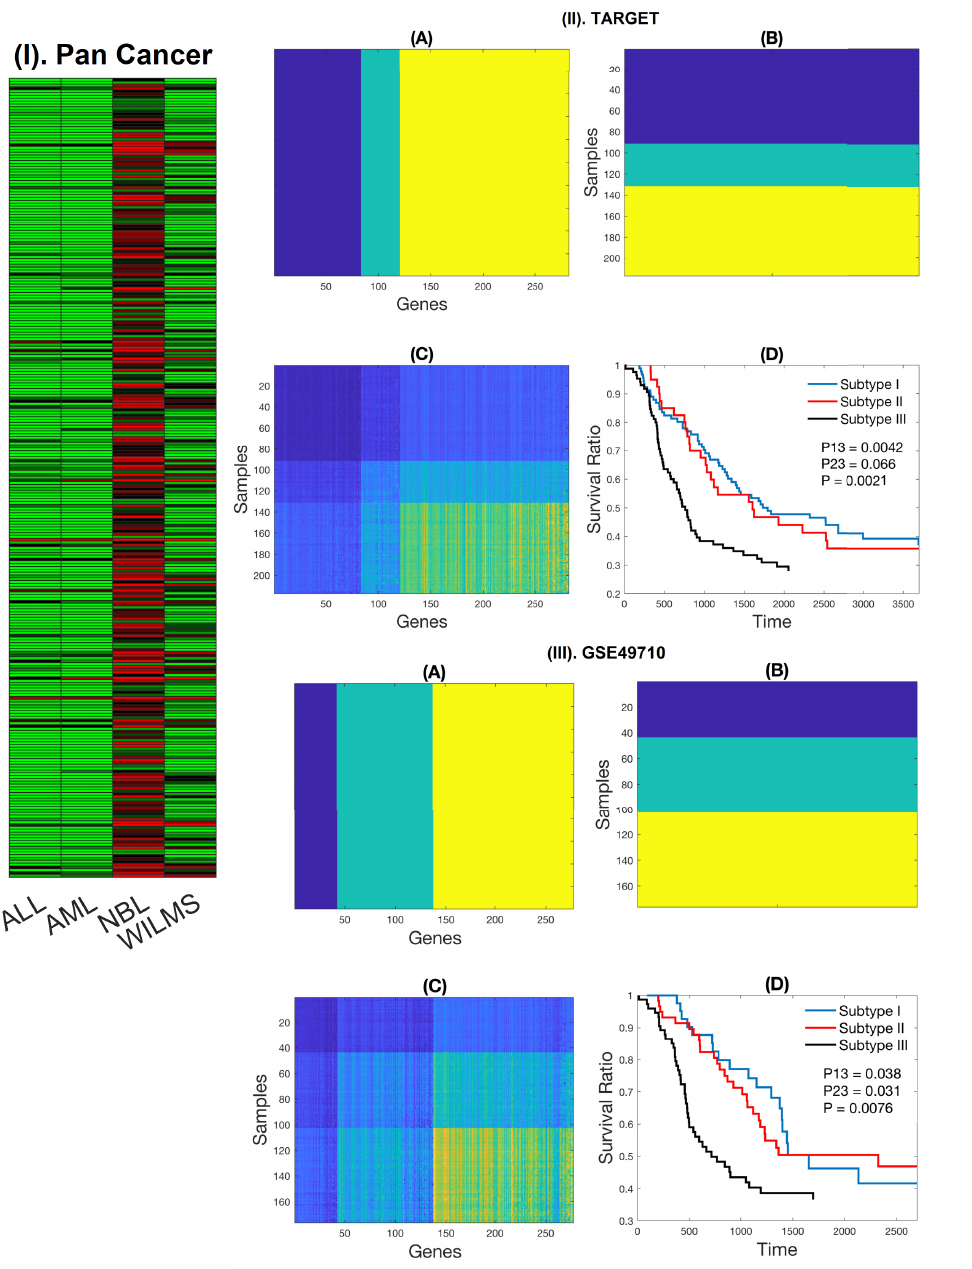
Figure 1. Co-clusters with 283 neuroblastoma (NB)-specific genes and their clinical relevance. ( I ) Heatmap with the average expression of 283 NB-specific immune-related genes in four pediatric tumors (data in Supplementary File S1). It shows that those genes are solely expressed in NB. ( II ), co-clustering with the 283 NB-specific genes of TARGET data. three clusters for both genes and samples are identified, leading to three clusters for patient samples. ( A ), visualization of clustering for genes. ( B ), visualization of clustering for samples. ( C ), visualization for both genes and samples. ( D ), Kaplan–Meier survival curve for three subtypes. ( III ), similar analysis with the 283 NB-specific immune gens in an independent cohort GSE49710. ( A – D ) are exactly the same analysis as ( II